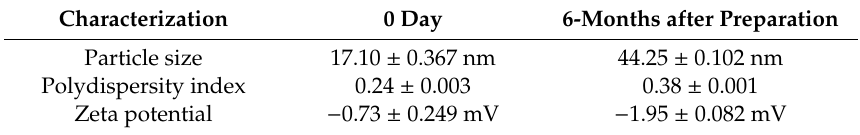
The stability assessments of self nano-emulsifying drug delivery system (SNEDDS) Formulation 1 (F1).